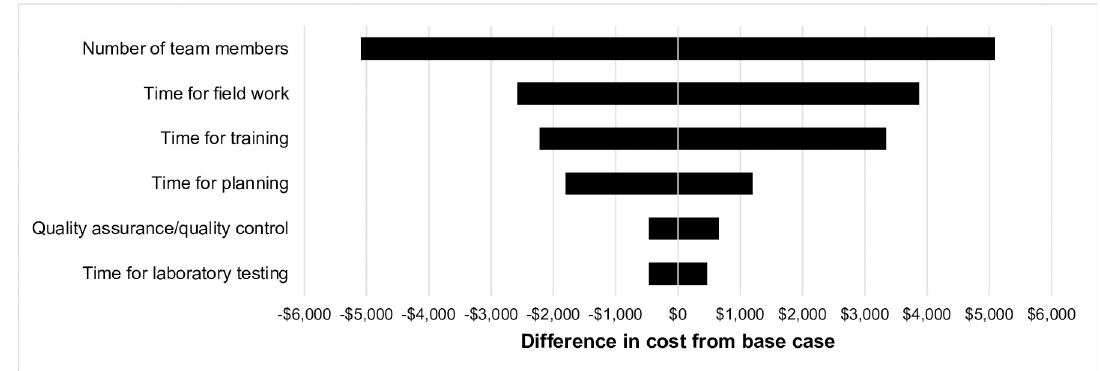
Fig 3. One-way sensitivity analyses of costs varying serosurvey parameters. One-way sensitivity analysis representing how varying parameters changed the total serosurvey cost from the base case of $68,558. Negative values (to the left) indicate lower cost than the base case, reflecting the lower end of the ranges, and the positive values (to the right) indicate higher cost than the base case, reflecting the higher end of the ranges. The number of team members varied from 2 to 6, the time for field work varied from 10 to 15 days, the time for training varied from 3 to 8 days, and the time for planning varied from 5 to 10 days. The percentage of specimens requiring retesting varied from 5 to 25% and the time for laboratory testing varied from 13 to 23 days. All costs are in 2016 USD.